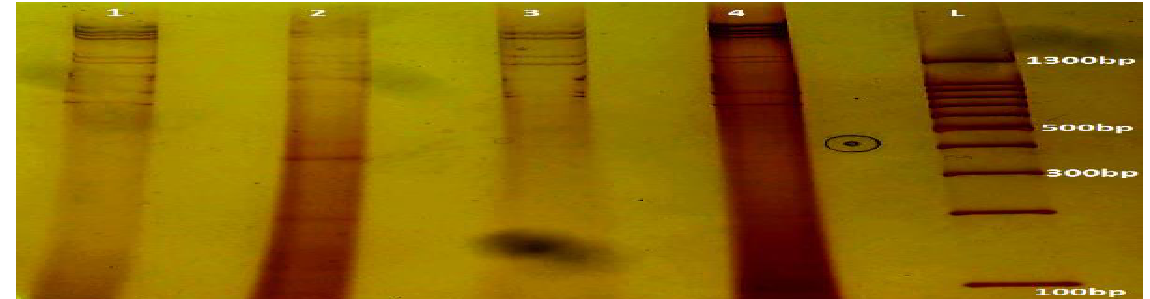
Figure 1. Non denatured polyacrylamide gel electrophoresis of rotavirus genomic dsRNA stained with silver stain. (lanes 1,2,3,and 4: represent Rotavirus genomic dsRNA segments, lane L: dsDNA 100bp